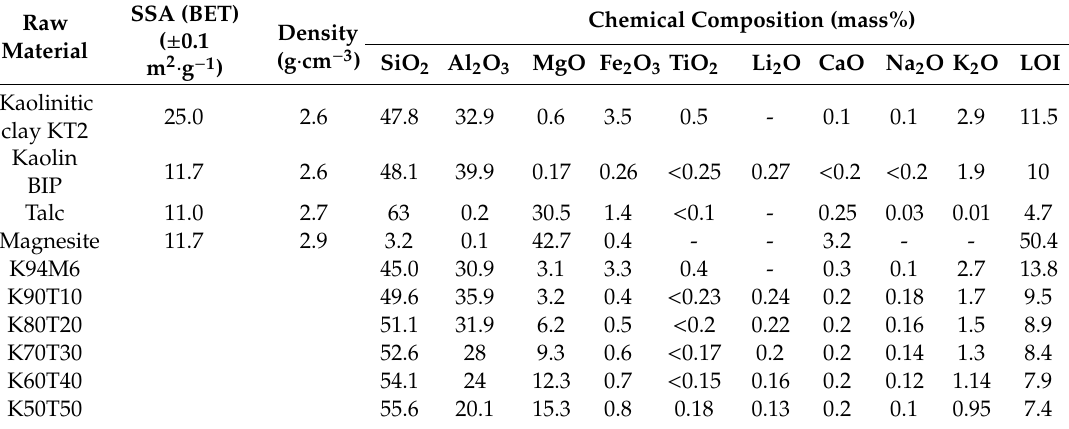
Table 1. Chemical composition (XRF analyses) and other characteristic physical properties of the starting powders. LOI, loss on ignition at 1050 ◦